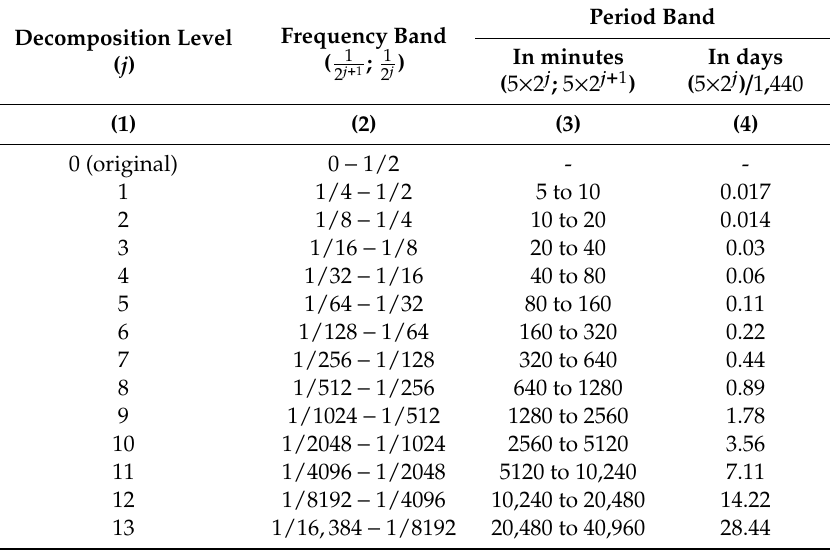
Table 1. Frequency bands of the first 13 decomposition